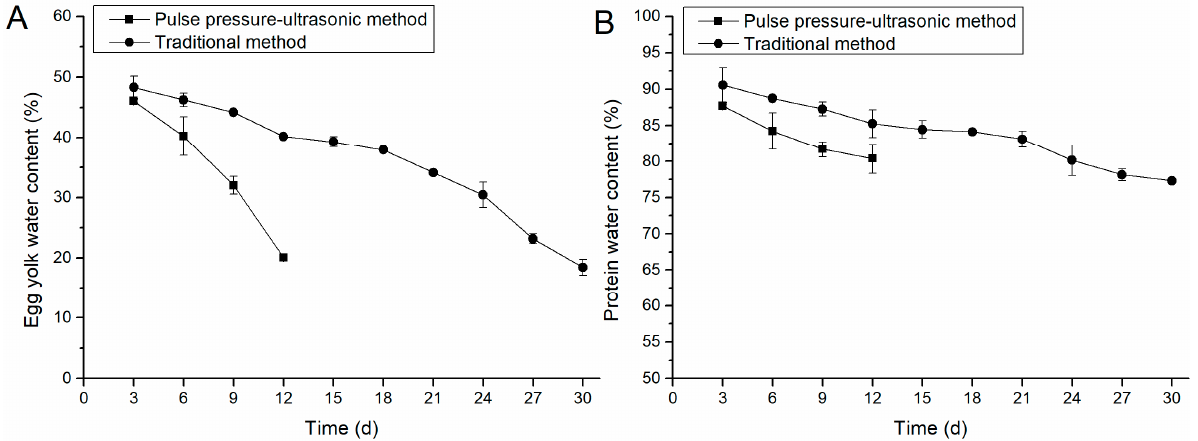
Figure 2. Comparison of moisture content in egg yolk and egg white. ( A ) illustrates the changes in egg yolk water content by pulse pressure-ultrasonic method and traditional method; ( B ) illustrates the changes of water content in egg white by pulse pressure-ultrasonic method and traditional method.